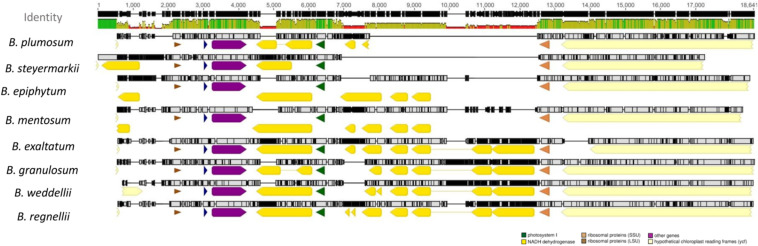
MAFFT alignment of the small single-copy (SSC) region of all plastid genomes. The yellow blocks represent the NDH genes. The green lines on the top represent the high similarity between the sequences, whereas red indicates the opposite. Genomes are organized in descending lengths.